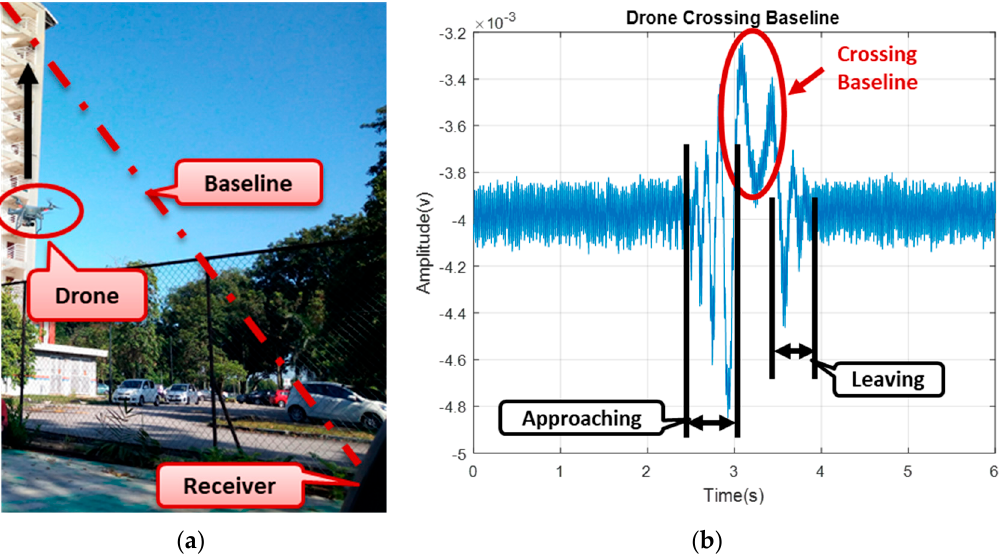
Figure 17. ( a ) Site view of Drone, crossing the baseline, ( b ) Raw received signal, showing the detected target’s linear